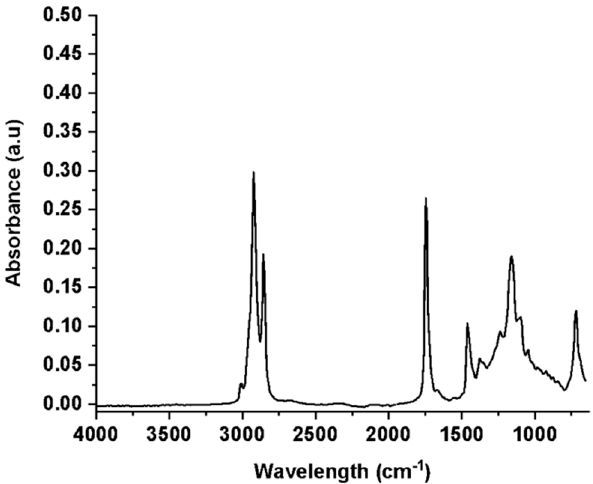
Figure 1. ATR-FTIR spectrum of green co ff ee oil. The analysis were performed in triplicate (n =